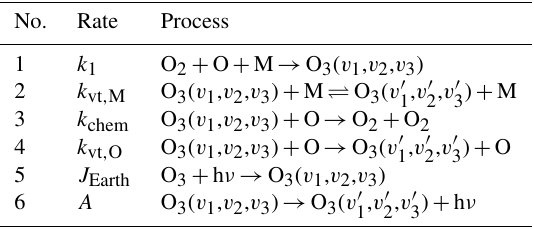
Table 2. Major photochemical reactions affecting O 3 in the meso- sphere and lower